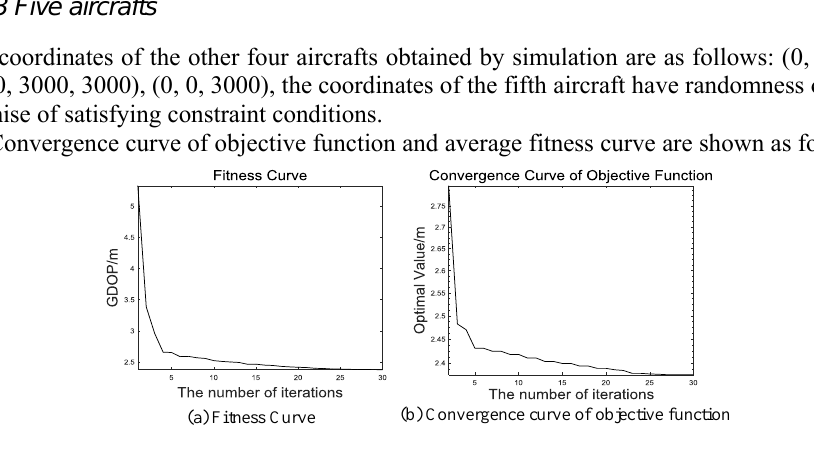
Fig. 4. Population mean fitness and target convergence curves -5